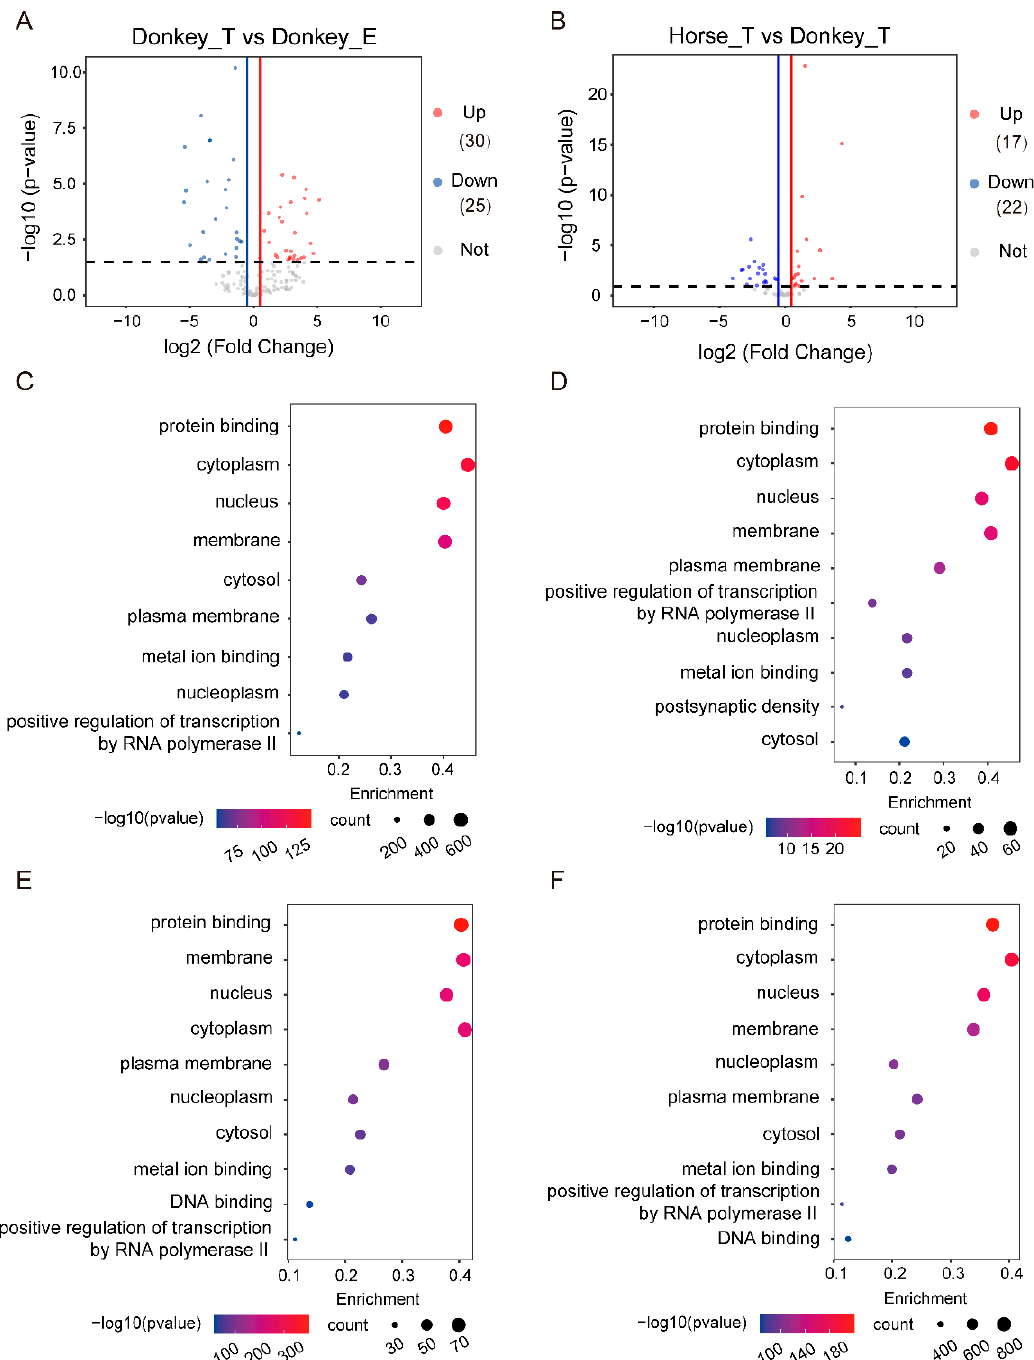
Figure 5. Functional analysis of tissue–specific miRNAs in testis and epididymis of the donkey. ( A ) Volcano plot of differentially expressed miRNAs in testis and epididymis tissues of the donkey. ( B )